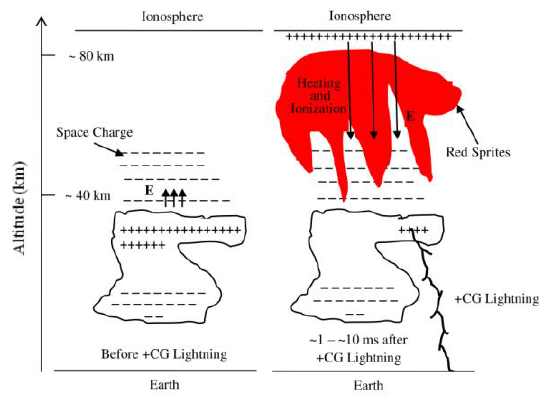
Fig. 4. Schematic of red sprites. Large Quasi-electrostatic field produces heating and ionization in higher altitudes resulting in red sprites. The figure is partly adopted from Pasko et al.